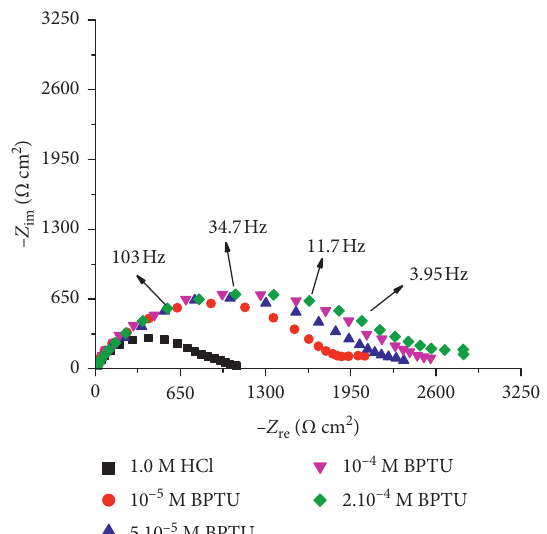
Figure 1: Nyquist plots for low carbon steel in 1.0M HCl without and with different concentrations of BPTU.